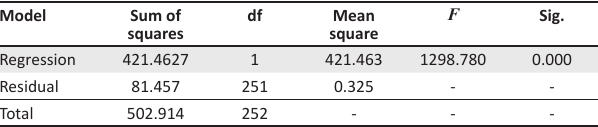
TABLE 5b: Influence of the intervening variable on the dependent variable. ANOVA. Model